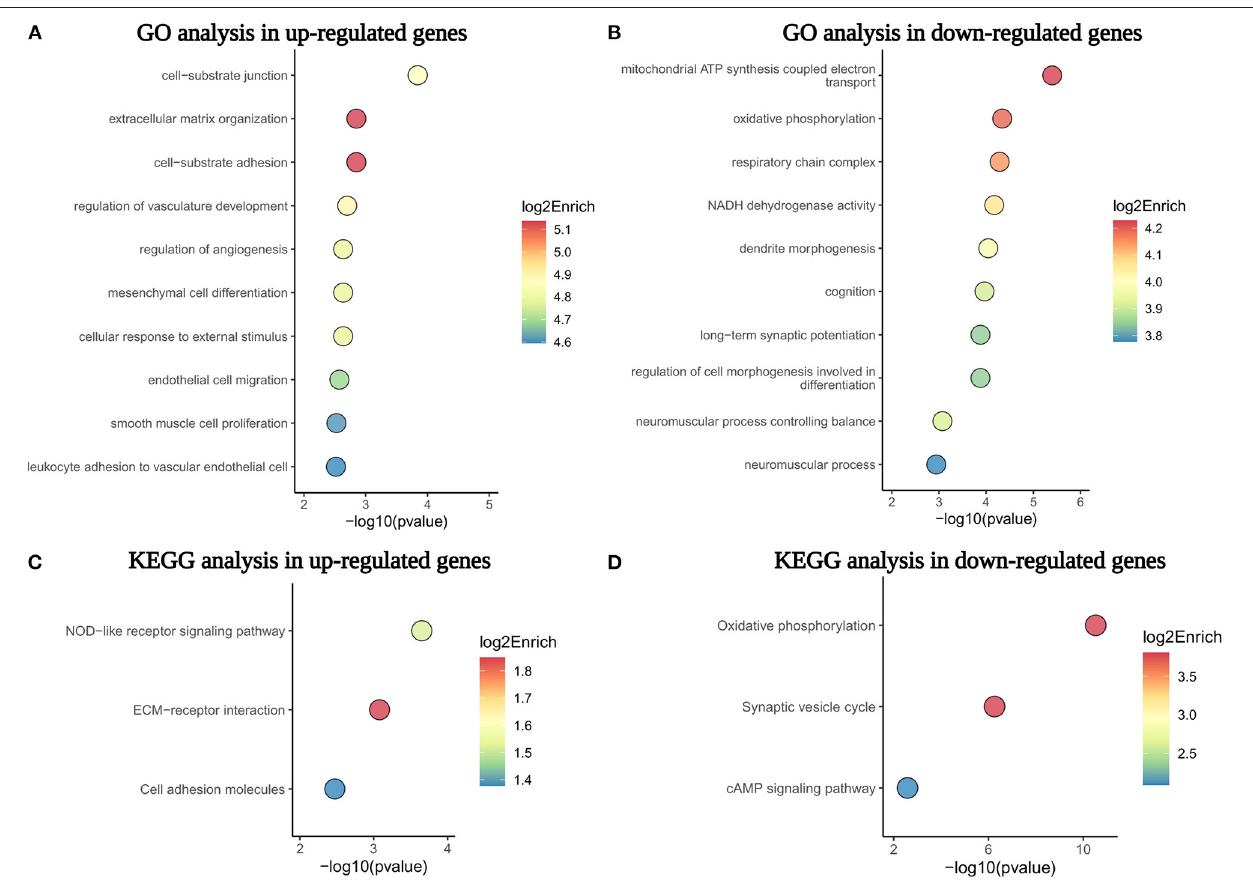
FIGURE 4 | The GO and KEGG pathway enrichment analysis of dysregulated genes in the MCA of patients with MMD. (A,B) Showed the top 10 GO biological processes enriched in upregulated and downregulated genes, respectively. (C,D) Displayed the top three KEGG pathways overrepresented in upregulated and downregulated genes. GO, Gene Ontology; KEGG, Kyoto Encyclopedia of Genes and Genomes; ECM, extracellular